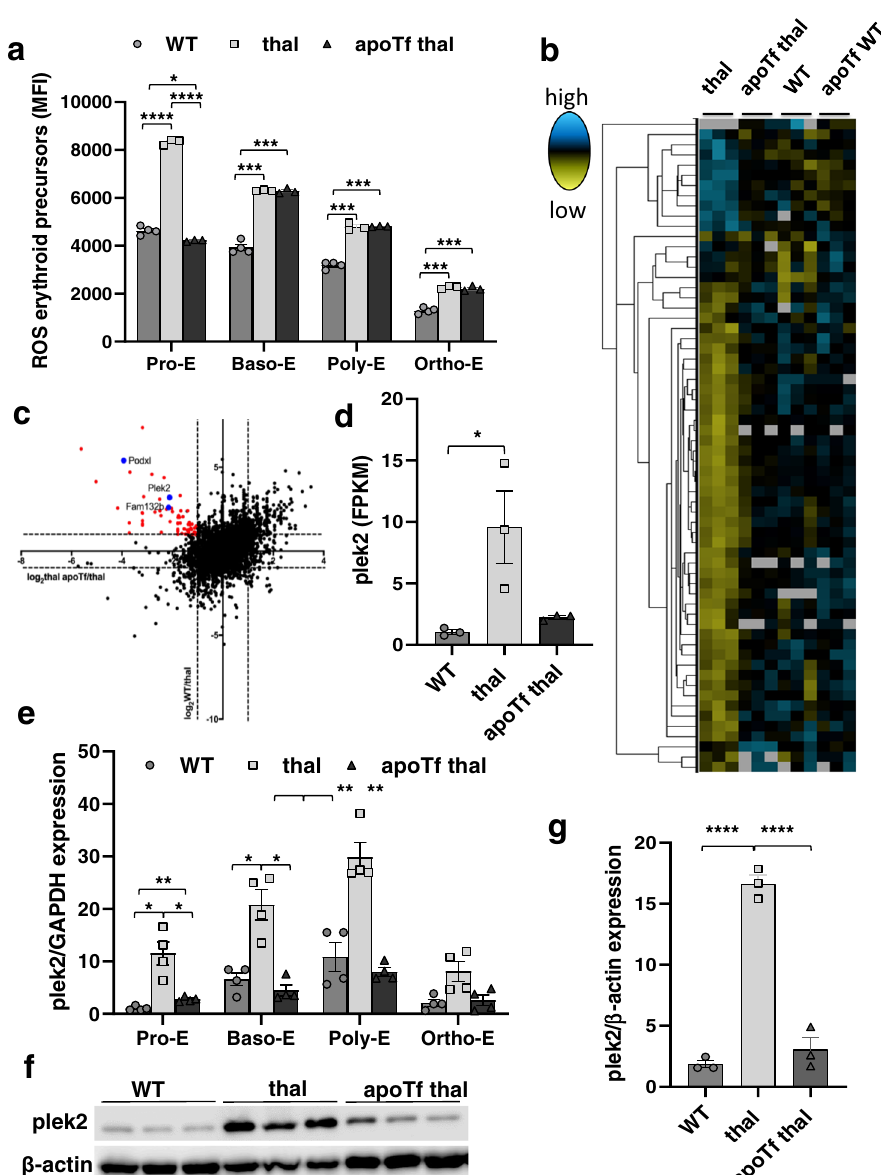
Fig. 1 Pleckstrin-2 is an important marker of ineffective erythropoiesis in β -thalassemic erythroblasts. a Flow cytometry analysis of MFI of erythroid precursor ROS from WT, β -thalassemic, and apoTf-treated β -thalassemic mice, as identi fi ed by CD44 and forward scatter ( n = 3-4 mice/group), demonstrating highest ROS in Pro-E stage progressively decreasing during erythroid differentiation, increased ROS at all stages in β -thalassemic relative to WT erythroblasts, and decrease in ROS only in Pro-E stages in apoTf-treated β -thalassemic erythroblasts. b Heatmap of RNA sequencing analysis showing expression levels (FPKM values) of transcripts that display signi fi cant differential expression patterns between β -thalassemic and WT Pro-E but correct after apoTf treatment in β -thalassemic mice. Figure represents 2 – 3 mice pooled per data point, n = 3 data points per group. c Log 2 -based fold change between comparisons WT/thal vs. thal apoTf/thal were plotted on y vs. x axes, respectively. Red data points represent genes whose expression increases in β -thalassemic relative to WT Pro-E and decreases in β -thalassemic Pro-E after apoTf treatment, revealing several genes of interest, e.g., plek2, and known genes that provide validation, e.g., Fam132b and Podxl. d Relative expression of plek2 from RNA sequencing analysis demonstrates signi fi cantly increased plek2 in β -thalassemic bone marrow Pro-E, which partially corrects after apoTf treatment. e Plek2 mRNA expression in sorted bone marrow samples to isolate progressive stages of erythroid differentiation from 2 – 3 mice pooled per data point, n = 4 data points per group WT, β -thalassemic, and apoTf-treated β -thalassemic mice, demonstrating increased plek2 mRNA expression in all four stages of erythropoiesis in β -thalassemic compared to WT erythroblasts, normalized in apoTf-treated β -thalassemic erythroblasts. f Plek2 protein expression in CD45 − bone marrow cells demonstrate increased plek2 in β -thalassemic mice compared to WT, and normalized in apoTf-treated β -thalassemic mice ( n = 3 mice/group, MW = plek2 38 kDa, actin 42 kDa). g Statistical analysis of the western blot in ( f ) for plek2 quanti fi cation. All data are reported as mean ± s.e.m. and p < 0.05 is considered statistically signi fi cant (( d and g ) ordinary one-way ANOVA; ( a and e ) two-way ANOVA)) (* p ≤ 0.05, ** p ≤ 0.005, *** p ≤ 0.0005). WT = wild type; apoTf = apo- transferrin; ROS = reactive oxygen species; MFI = mean fl uorescence index; Pro-E = pro-erythroblasts; Baso-E = basophilic erythroblasts; Poly-E = polychromatophilic erythroblasts; Ortho-E = orthochromatophilic erythroblasts; plek2 = pleckstrin-2; FPKM = fragments for kilobase